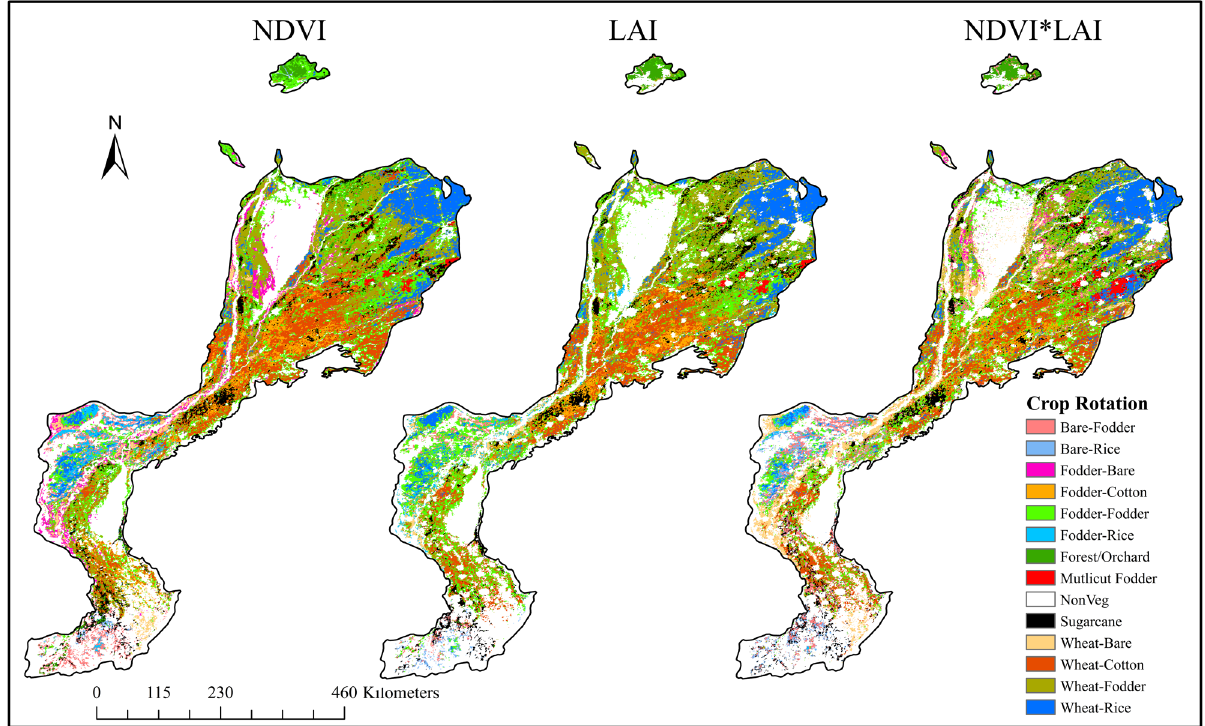
Figure 6. Spatial distribution of different crop rotation in study region derived from NDVI, LAI and